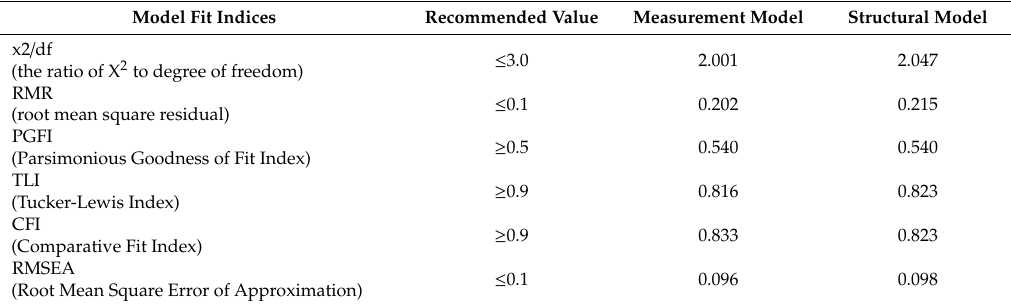
Table 2. Fit indices for BIM Acceptance model 2019.